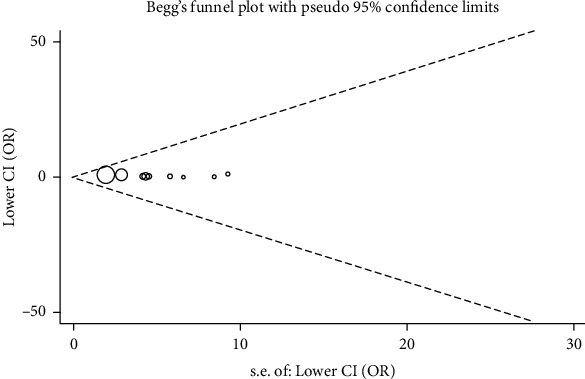
Begg's funnel plot for publication bias in the GG vs. TT comparison. Each point represents a separate study for the indicated association.